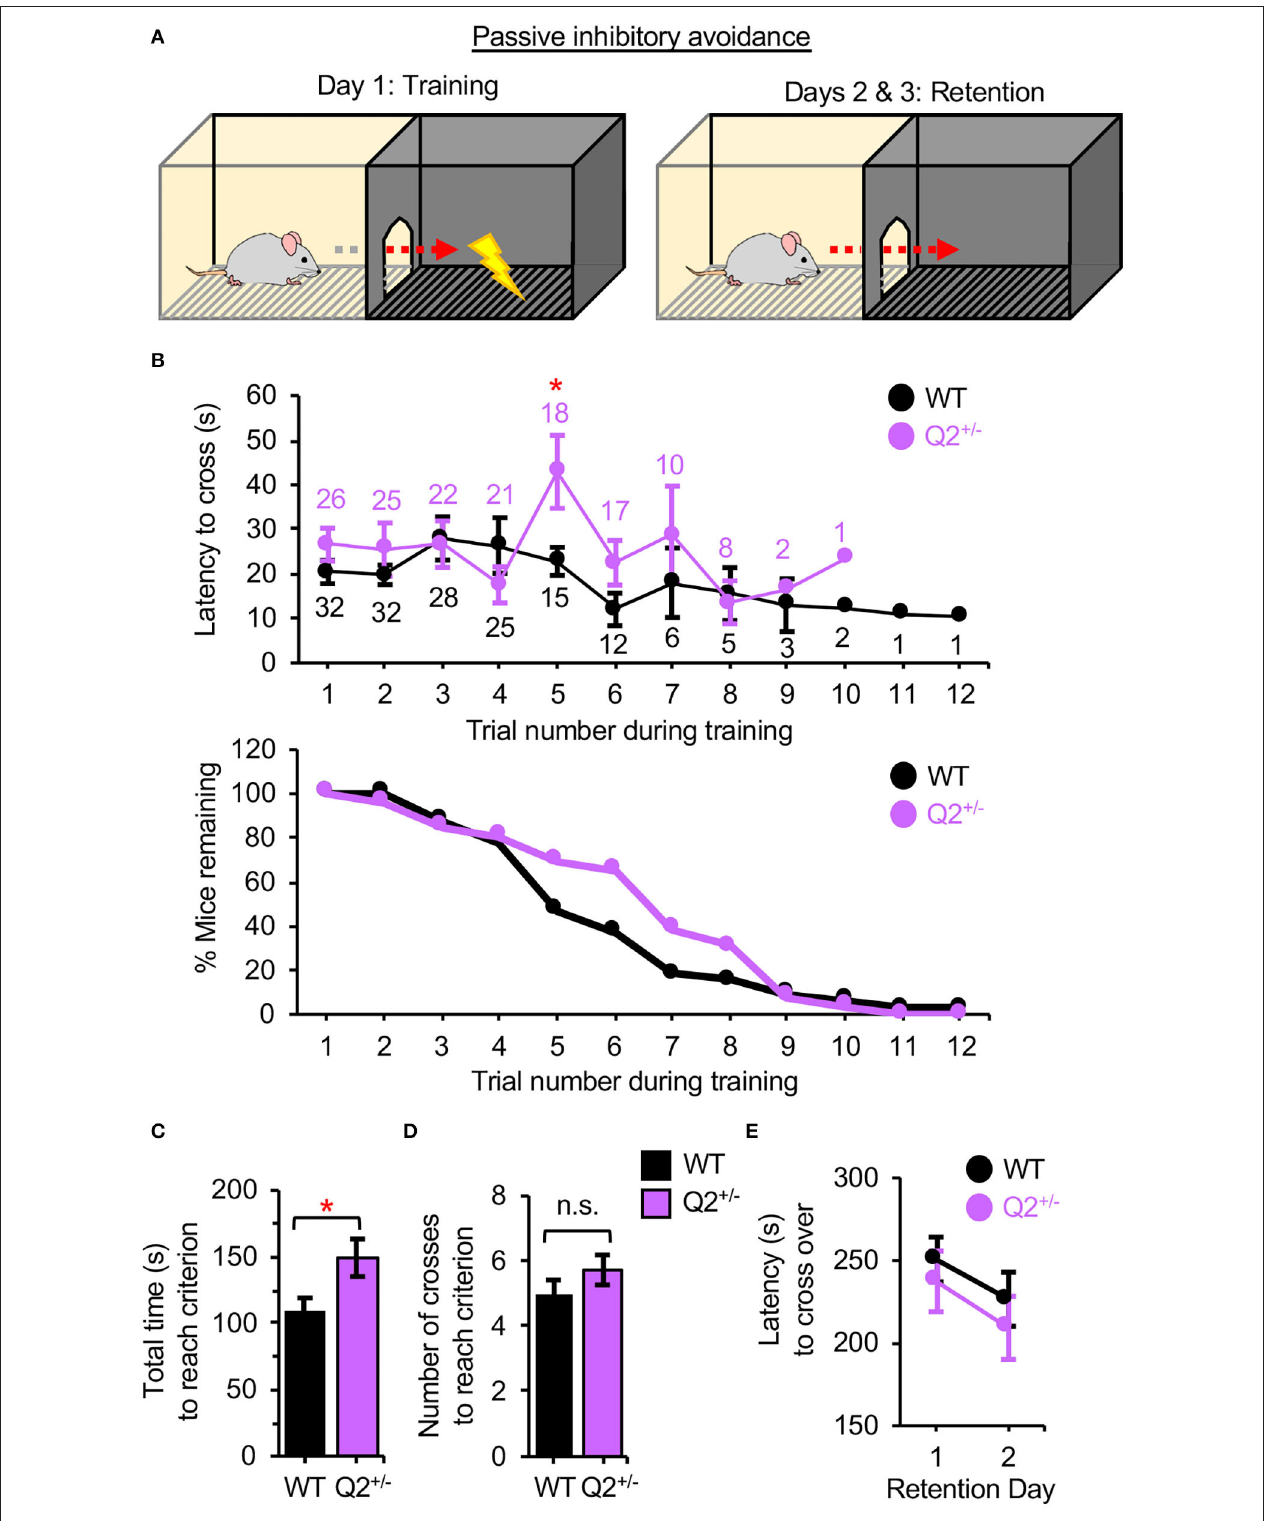
FIGURE 1 | Heterozygous loss of Potassium Voltage-Gated Channel Subfamily Q Member 2 ( KCNQ2 ) increases the total time to reach criterion during training on an inhibitory avoidance (IA) task but does not affect memory in mice. KCNQ2 + / + (wild-type; WT) mice and KCNQ2 + / − (Q2 + / – ) mice at age 4–6 months were subjected to passive IA test. (A) The design of the passive IA test. On the training day, the criterion for fear-motivated learning is established when the mouse remains in the lit